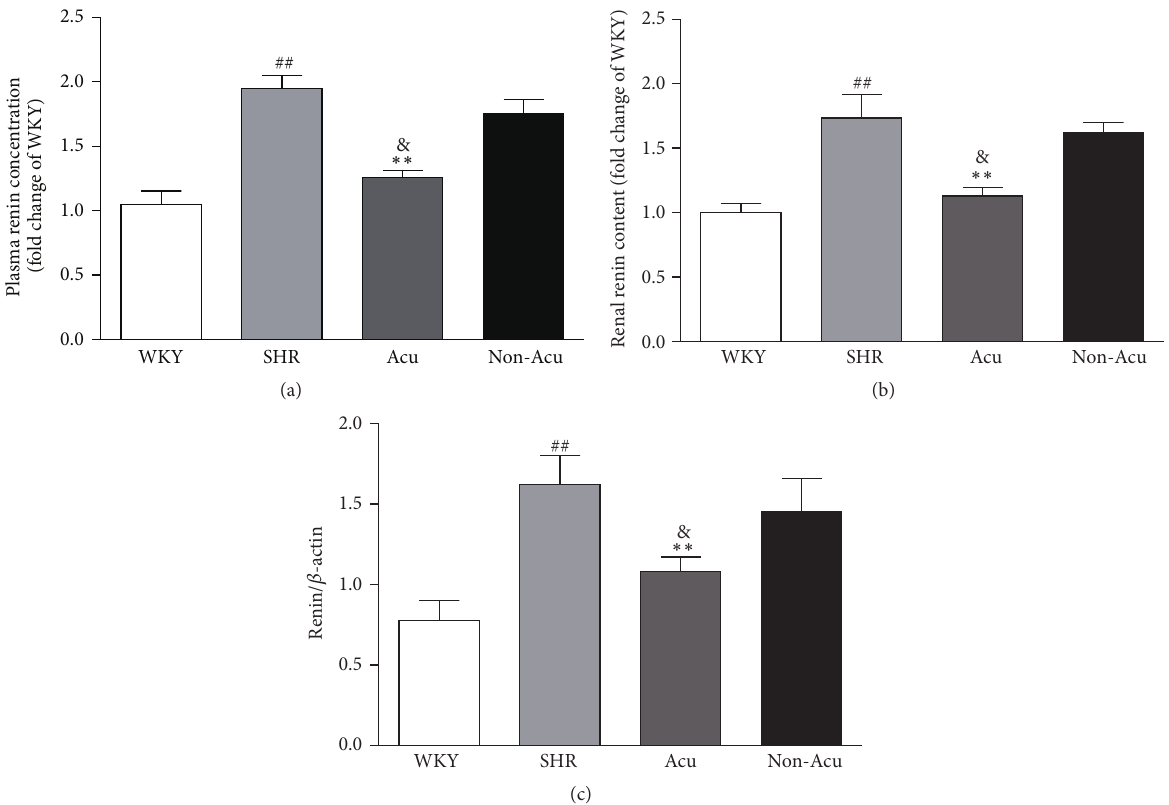
Figure 4: Effects of acupuncture on renin content (a and b) and renin mRNA expression (c). Data are presented as mean ± SEM ( 𝑛 = 10 rats). ## indicate 𝑃 < 0.01 , compared with the WKY group; ∗∗ indicate 𝑃 < 0.01 , compared with SHR group; & indicate 𝑃 < 0.05 , compared with Non-Acu